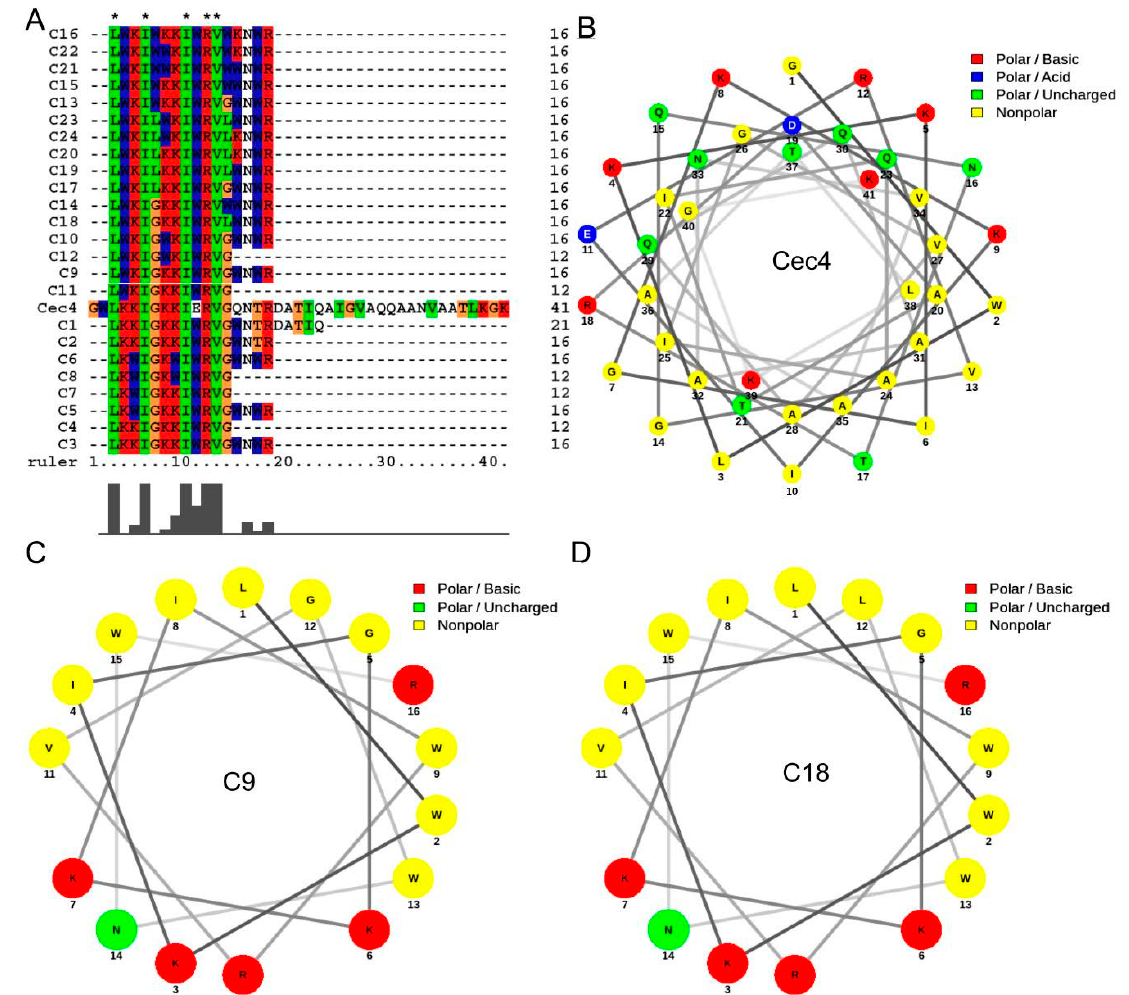
Figure 1. Small peptide sequences: alignment and helical wheels. ( A ) Sequenced alignment of Cec4-derived peptides with parental peptide. It shows the changes and relative positions of the amino acids of the derived peptide and the parental peptide. Multiple alignments were performed using the ClustalW program. The symbol (*) indicates that the aligned residues are identical. ( B – D ) The helical wheels of Cec4, C9 and C18 were shown respectively. The helical wheels were constructed with NetWheels (http://lbqp.unb.br/NetWheels/).